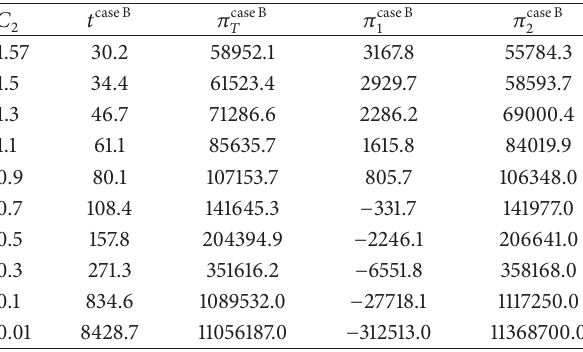
Table 4: The optimal customization degree factor and the optimal profit when the customization degree is dominated by